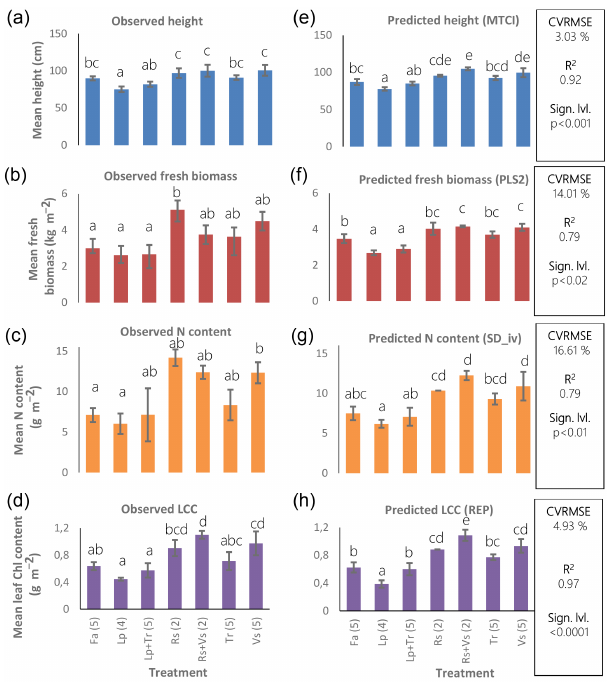
Figure 6. Mean and standard deviations of observed (a–d) and pre- dicted (e–h) plant trait values in A. sativa per plant legacy treat- ment for the validation plots ( n = 28). Bars with different letters above them indicate that the treatments are significantly different at p < 0 . 05 for the respective plant trait. The statistics to the right hand of the figure relate to statistical interference of the means of the observed and predicted values (plant legacy treatments: Fa, fallow; Lp, Lolium perenne ; Rs, Raphanus sativus ; Tr, Trifolium repens ; Vs, Vicia sativa ; CVRMSE, coefficient of variation of the root mean square error; R 2 , coefficient of determination; Sign. lvl., signifi- cance